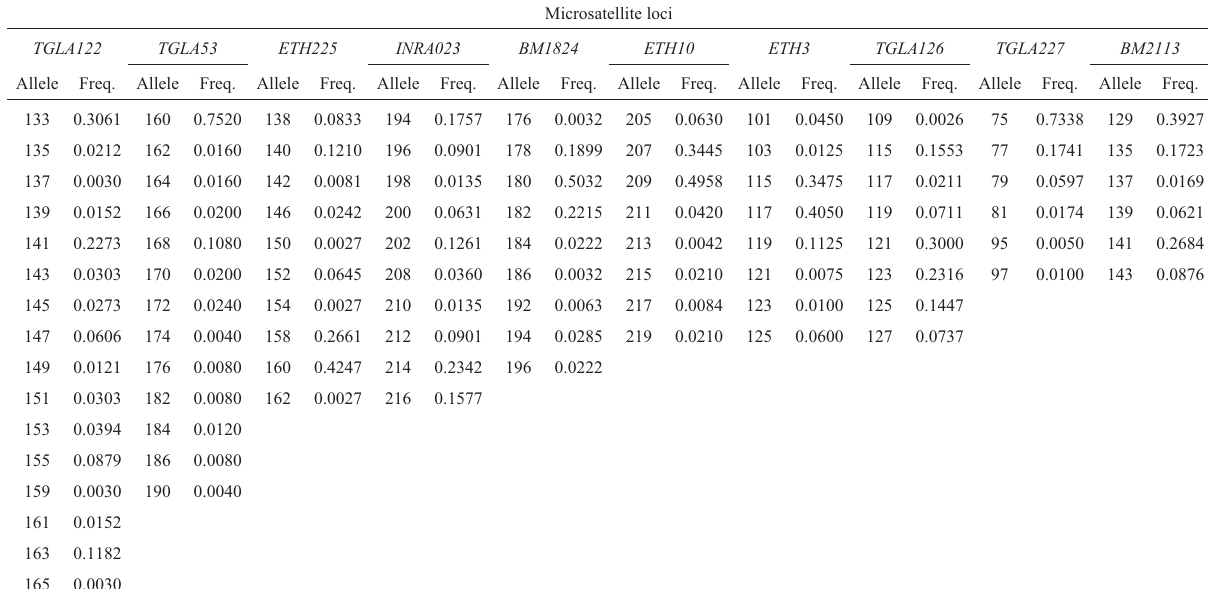
Table 2 - Allele frequencies (Freq.) of the ten microsatellite loci analyzed. Microsatellite loci Allele Freq. Allele Freq. Allele Freq. Allele Freq. Allele Freq. Allele Freq. Allele Freq. Allele Freq. Allele Freq. Allele Freq.